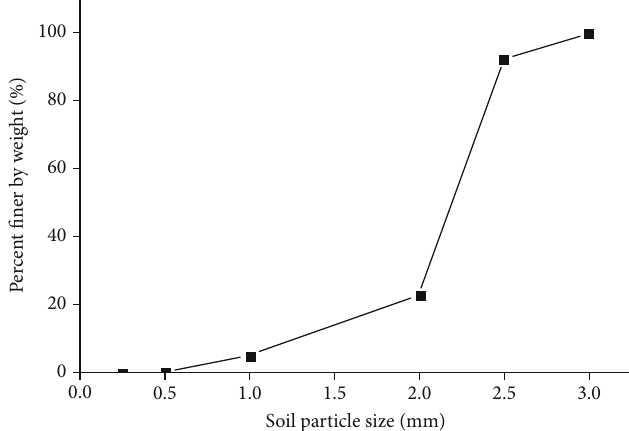
Figure 1: Initial gradation of calcareous sand.